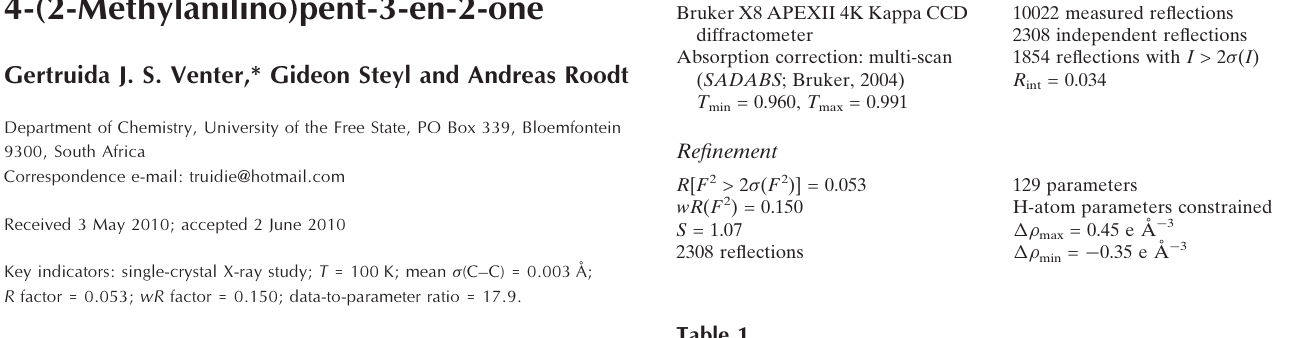
Hydrogen-bond geometry (A˚ , (cid:3) ).